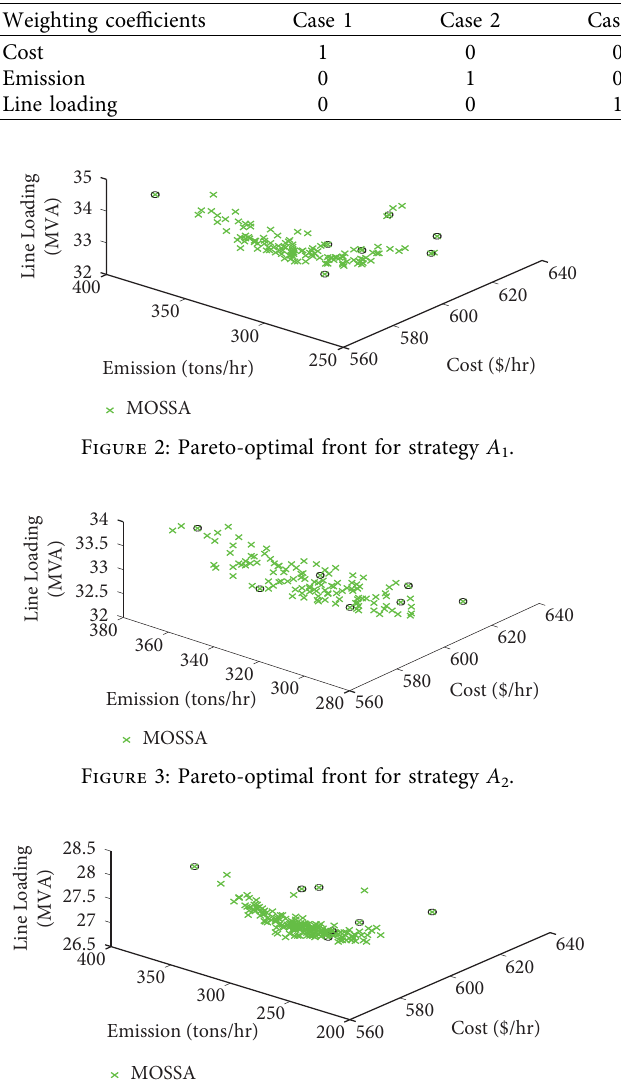
Figure 4: Pareto-optimal front for strategy A